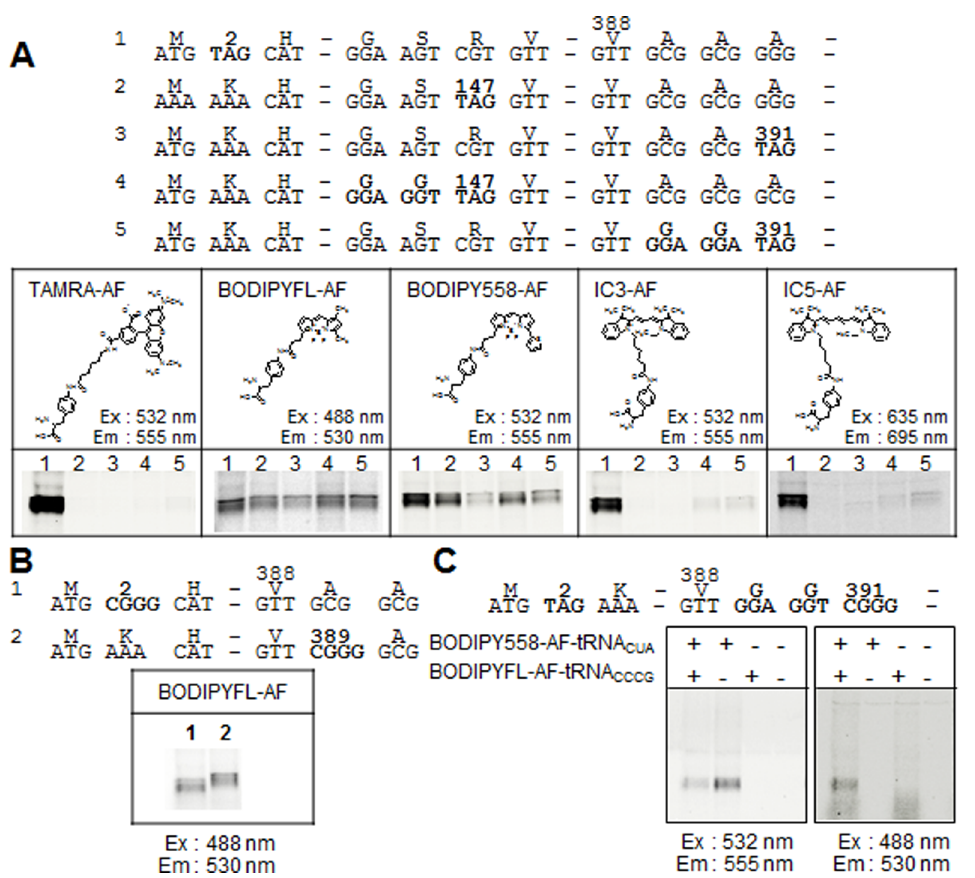
Fig. 5. Incorporation of fluorescent non-natural amino acids into NhaA. (A) Five version of NhaA (1–5) with introduced amber (TAG) codons (or Gly- Gly-TAG, introduced changes in bold) that enable incorporation of fluorescent non-natural amino acids into the N-terminal, middle or C-terminal regions of the protein (top panel) were expressed in the insect cell-free translation and translocation system in the presence of different fluorescent non-natural amino acids. The valine (V388) at the C-terminal end of NhaA was fused to additional sequences in the linker of the vectors (Table 1). Labeled NhaA protein was subjected to SDS-PAGE and fluorescent images were taken at the indicated excitation and emission wavelengths (bottom panel). The structure of the different fluorescent non-natural amino acids used in the experiments is shown above the gel images. (B) Incorporation of fluorescent non-natural amino acids into N-terminal or C-terminal positions in NhaA at an introduced four-base codon (CGGG) (top panel). NhaA was synthesized using the cell-free translation and translocation system in the presence of BODIPYFL-AF, subjected to SDS-PAGE and fluorescent images taken at the indicated excitation and emission wavelengths (bottom panel). (C) Double-labeling of NhaA by incorporation of BODIPY558-AF at an amber codon introduced into the N-terminal region and BODIPYFL-AF at the CGGG four-base codon introduced into the C-terminal region (top panel). NhaA was synthesized using the cell-free translation and translocation system in the presence of one or both fluorescent amino acids. Images of the SDS-PAGE were taken at the two different excitation and emission wavelengths indicated (bottom panel).